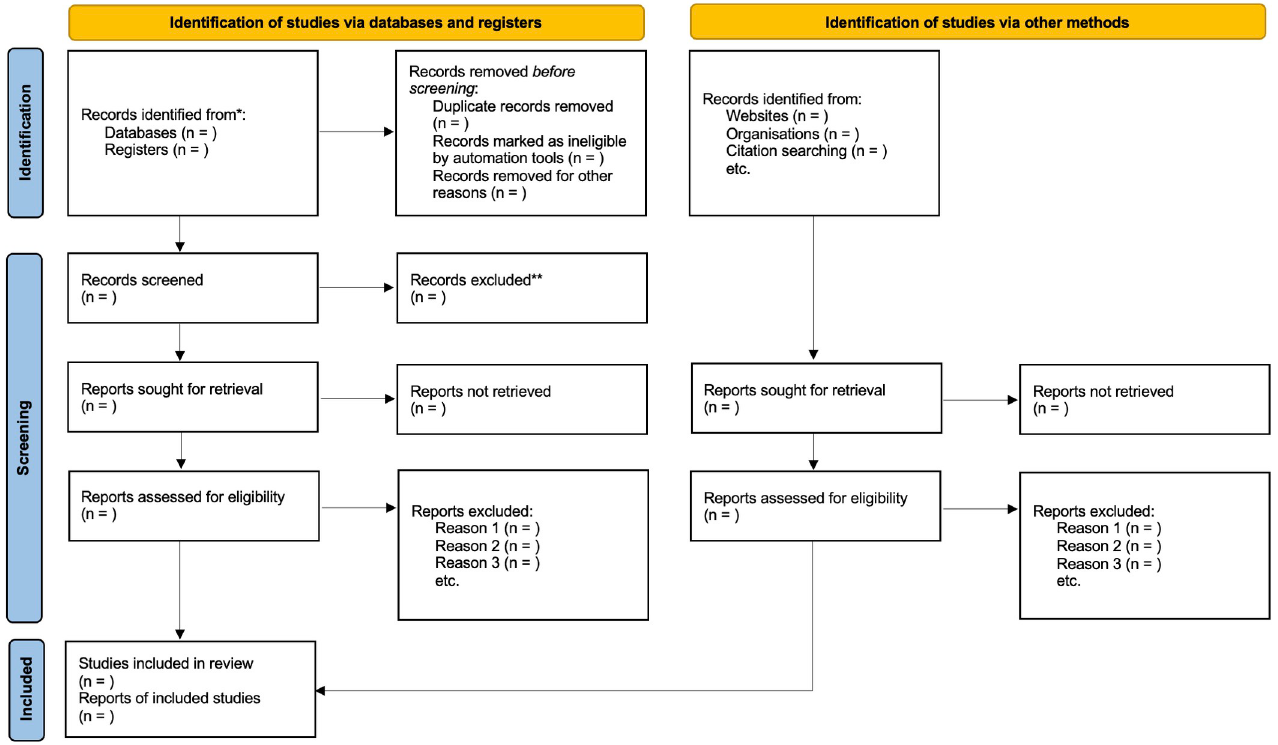
Fig 1. PRISMA flowchart [38].